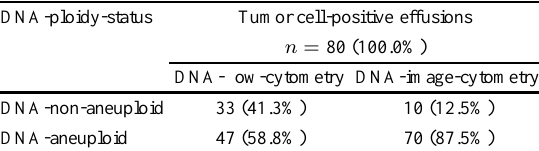
Prevalence of DNA-aneuploidy in effusions of primary and sec- ondary tumors serous of the membranes (DNA-flow- and -image-